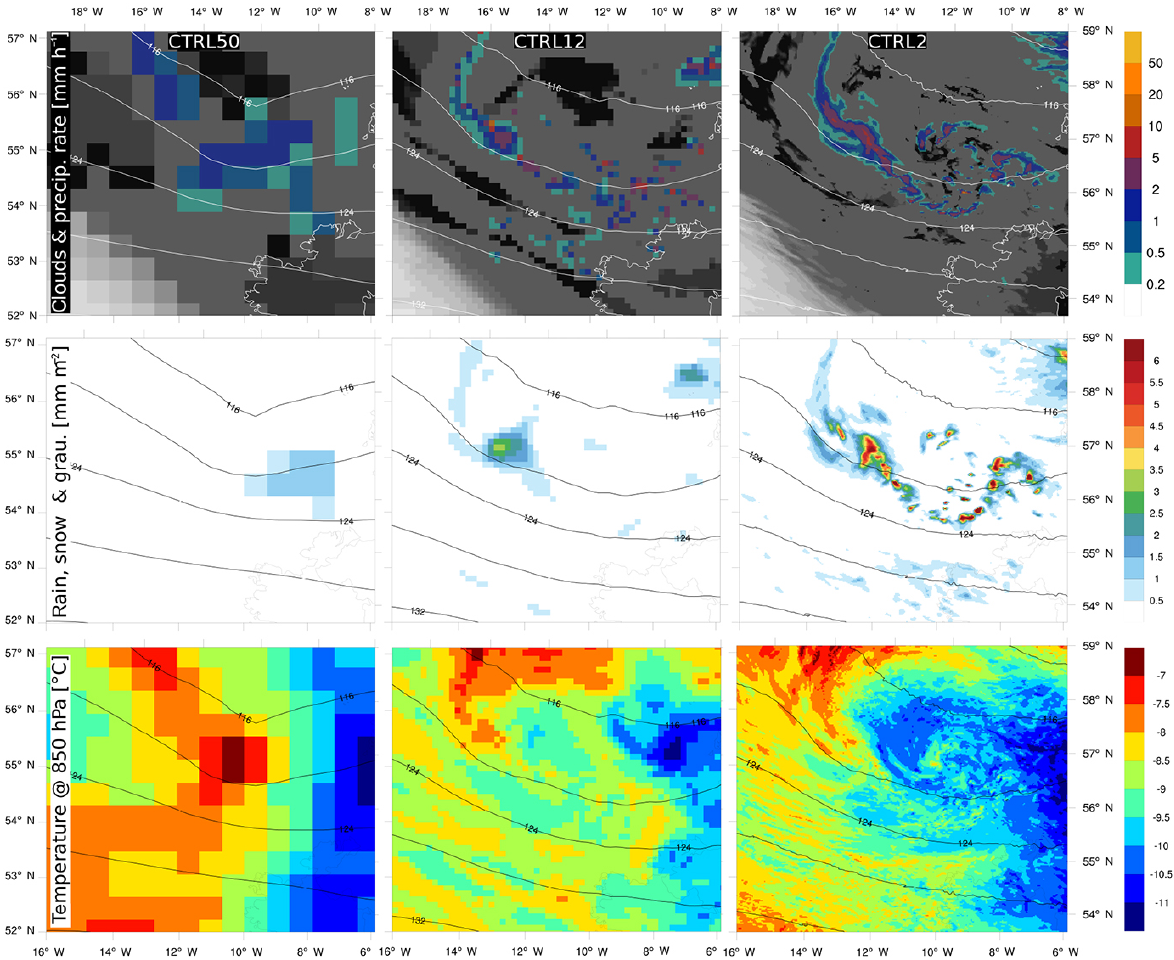
Figure 6. Representation of a meso-scale low with increasing grid spacing; (left column) CTRL50, (middle column) CTRL12 and (right column) CTRL2. (Top) colored shading indicates the rain rate [mmh − 1 ], the white shading the cloud cover visualization, and the white contours geopotential height at 850hPa [gpdm], (middle) vertically integrated sum of snow and graupel hydrometeors [mmm − 2 ], and (bottom) temperature at 850hPa [ ◦ C]. For the location of the meso-scale low please consult Fig. S4 in the Supplement.